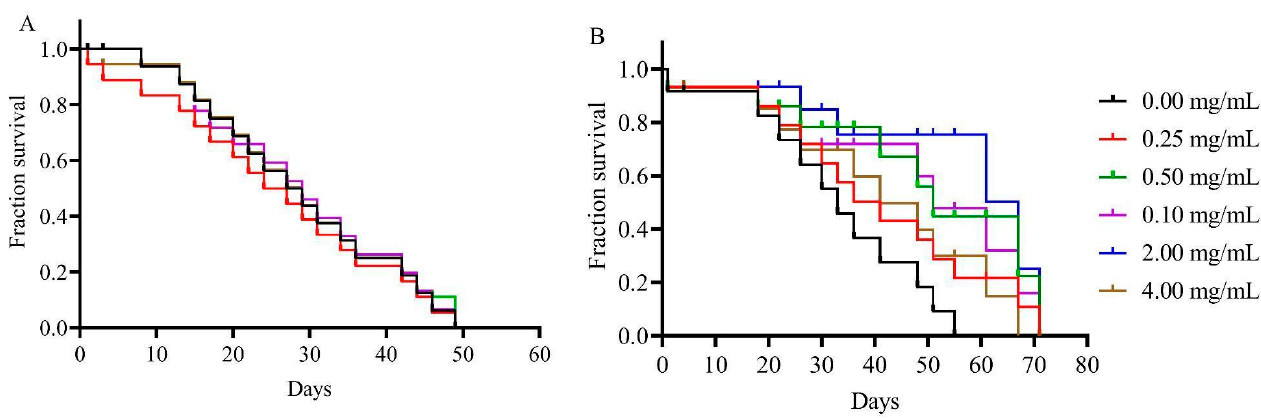
Figure 8. Larval exposure to TiO 2 and Eu 3+ -doped TiO 2 does not interfere with adult lifespan. Drosophila adults that developed in standard medium containing TiO 2 ( A ) or Eu 3+ -doped TiO 2 ( B ) nanocrystals did not show any significant decrease in adult survival. Data are represented as the log of the percentage of flies that are alive at each age.